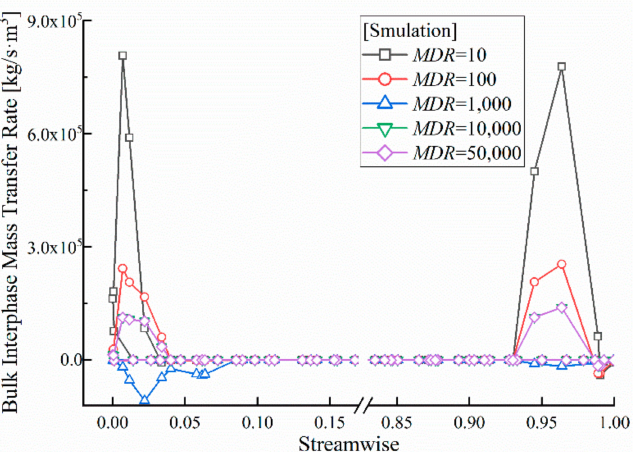
Figure 34. Bulk interphase mass transfer rate on stator blade at stall under various maximum density ratios.